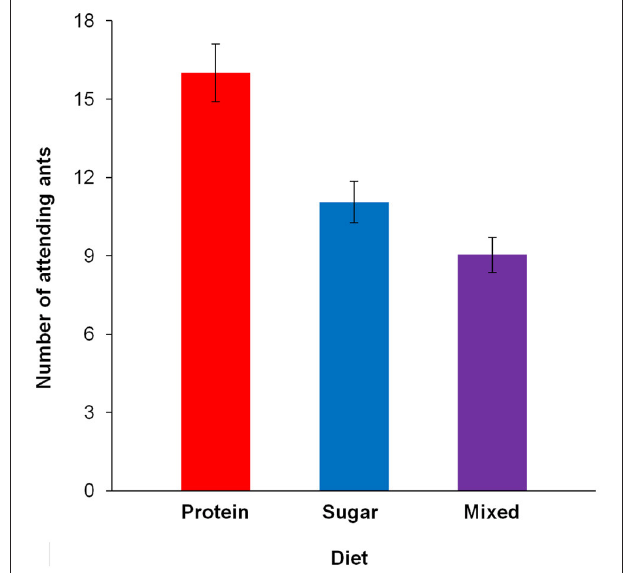
FIGURE 3 | The number of ants tending the caterpillar after 30min, depending on the diet. Estimated means and standard error bars are given. Continuous predictors are fixed at the following mean values: caterpillar weight = 179.12mg; 16 days after